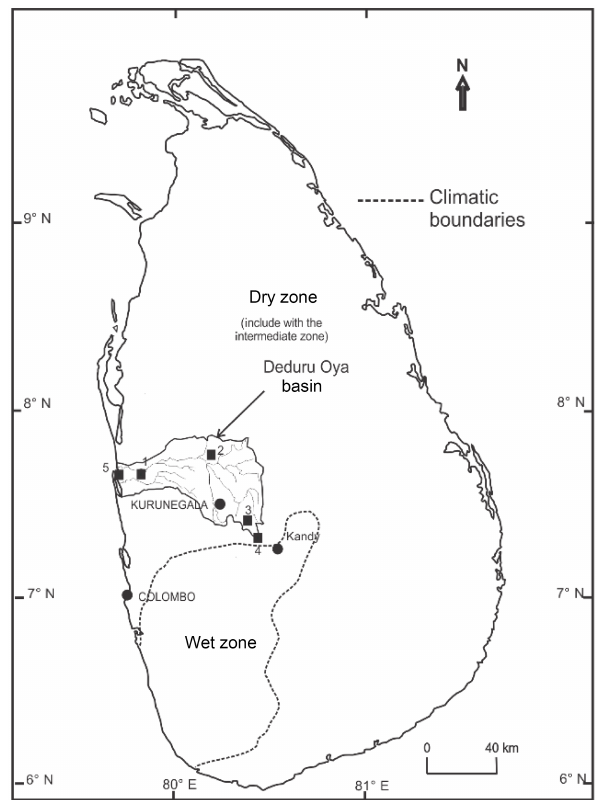
Figure 1. Sri Lanka showing climatic zones (modified after Muththuwatta and Liyanage, 2013), and study GN